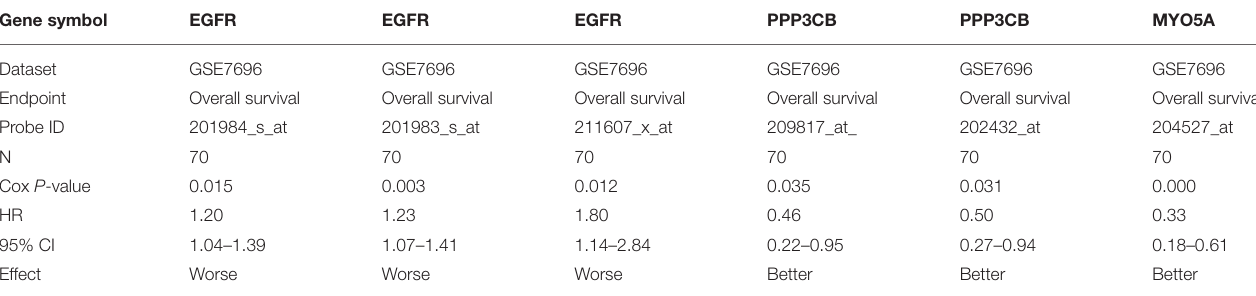
TABLE 4 | The association of hub gene expression and the survival in patients with